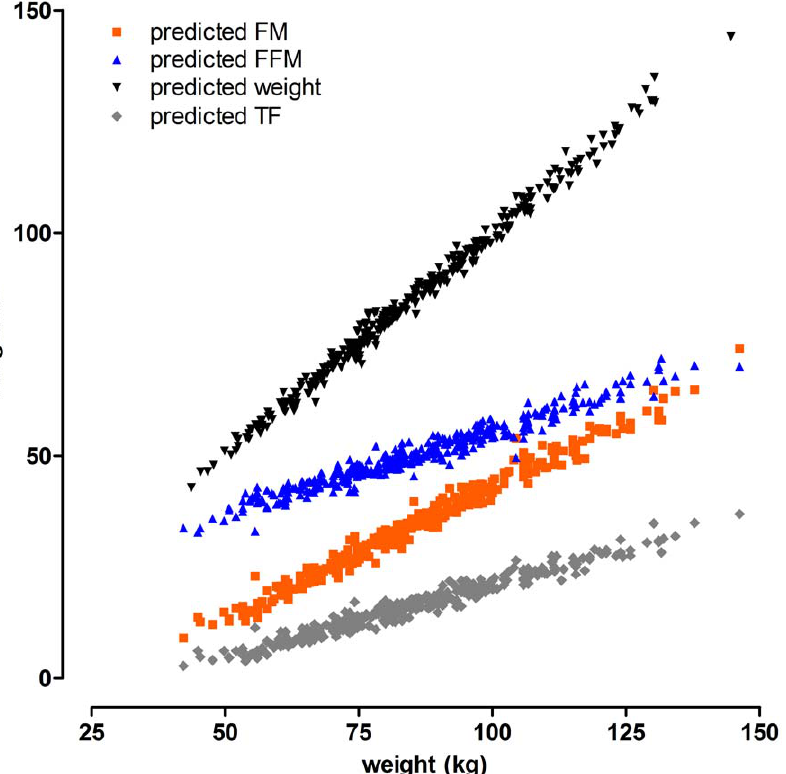
Figure 2. FM increases faster than FFM as a function of weight. Relationships between predicted body composition and weight (abscissa) to DXA-determined values (ordinate) for the full DXA population (IG + CV) are linear and show that with increasing mass, TF and FFM increase at similar rates which are less than for the total FM. Predicted weight is the sum of FFM and FM (see text for discussion).